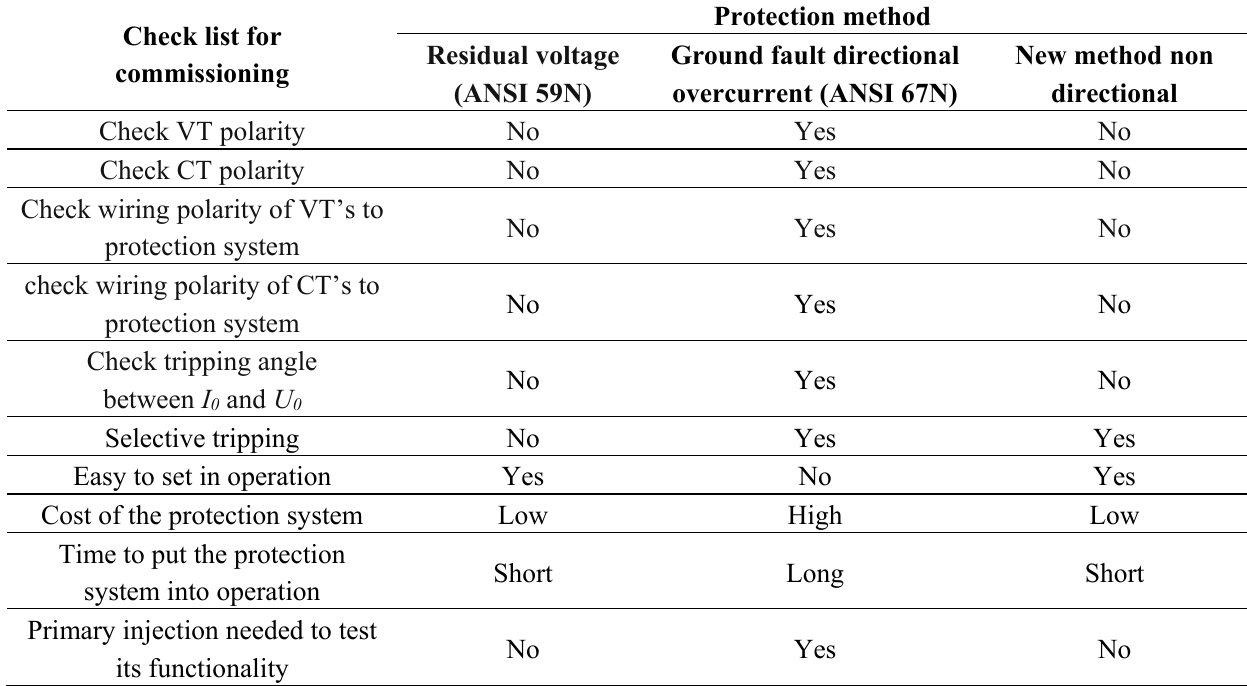
Table 3. Comparison of the main features of the protection methods used nowadays to detect and clear SPGF at neutral ungrounded